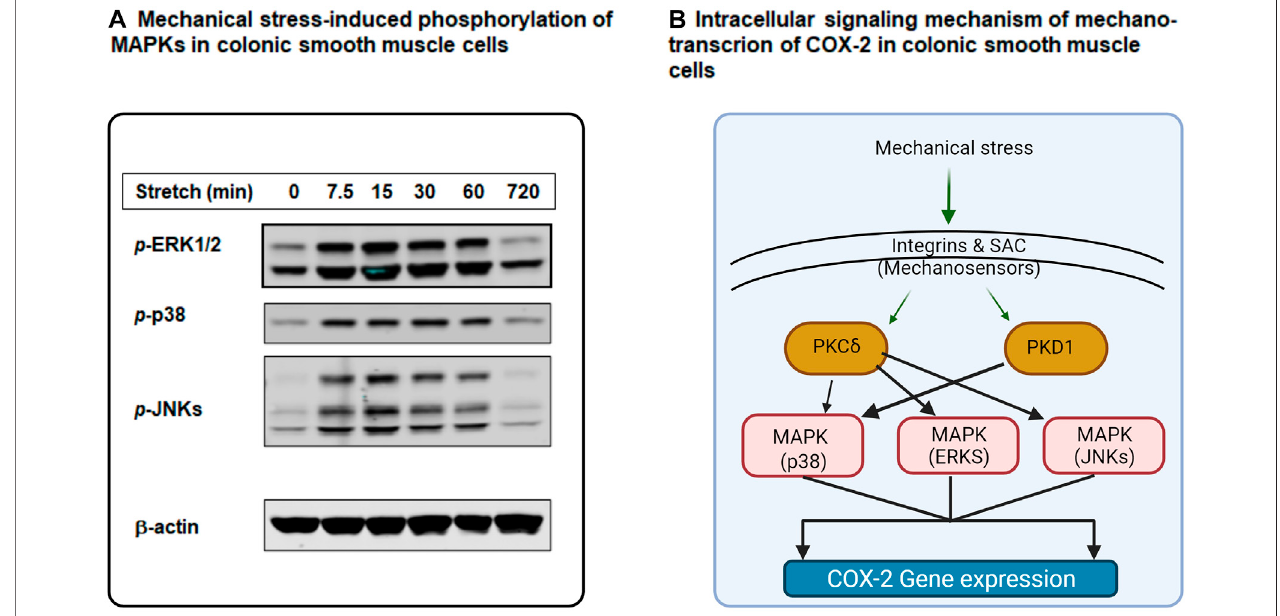
FIGURE 3 | Intracellular signaling mechanisms of mechano-transcription of COX-2 in colonic smooth muscle cells (SMC). (A) Mechanical stretch (18%) induced robustphosphorylationofMAPKsERK1/2,p38,andJNKsinculturedratcolonicSMCinatime-dependentmanner. (B) MechanicalstimulationongutSMCissensedby integrins and SAC (stretch-activated ion channels) at the cell membrane level. These mechano-sensors transduce mechanical signals tointracellular signaling pathways involvingPKC(i.e.,PKC δ ),PKD(PKD1),andMAPKs(p38,ERKs,andJNKs),leadingtomechano-transcriptionofCOX-2incolonicSMC.Morespeci fi cally,PKC δ is linked to MAPKs ERKs, p38, and JNKs, whereas PKD1 is coupled to MAPK p38. Some parts of the fi gure are adapted with permission from Figure 2 of Shi (2017).